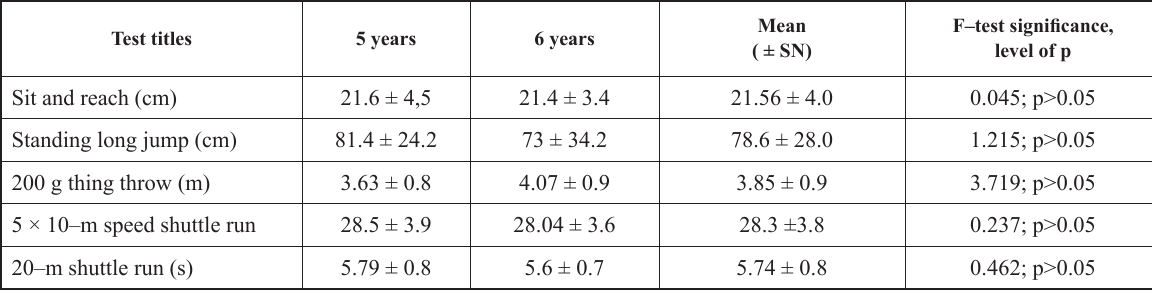
Table 2. Results of physical capacity tests of pre-school children in terms by age